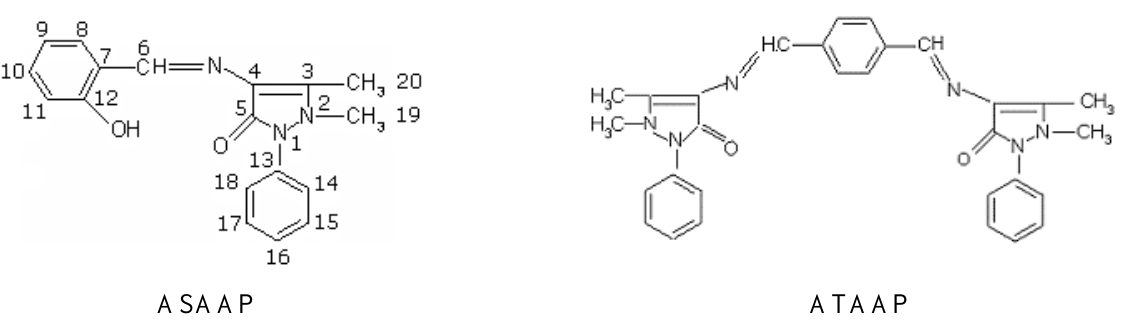
Figure 1 . Ligand